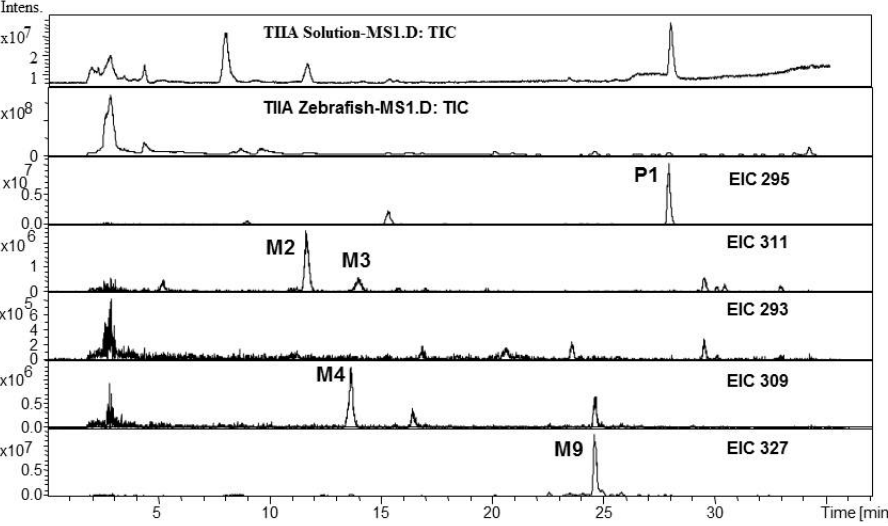
Figure 2. Total ion chromatogram and extracted ion chromatograms for TIIA after exposure to zebrafish for 24 h.